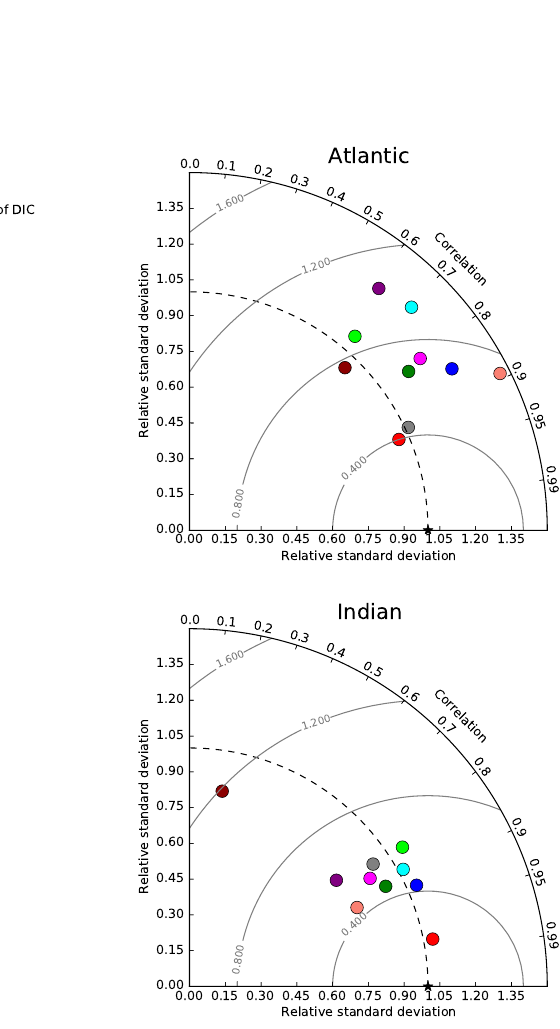
Figure A1. Taylor diagram (Taylor, 2001) for global and basin-wide volume-weighted oceanic tracer distributions as simulated by the Bern3D standard set-up with k dia = 0 . 2 × 10 − 4 m 2 s − 1 . Observation-derived fields are taken from GLODAP (Key et al., 2004) and